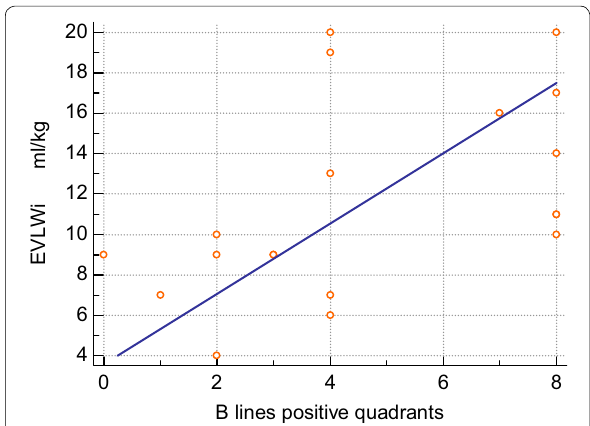
Fig. 1 Correlation between the number of chest quadrants positive for B-lines at lung ultrasound and the values of EVLW/kg ABW. Spear- man (rho) rank correlation test: sample size—19; Spearman’s coeffi- cient of rank correlation (rho)—0.162; significance level— p 95% confidence interval for rho—0.219 to 0.834